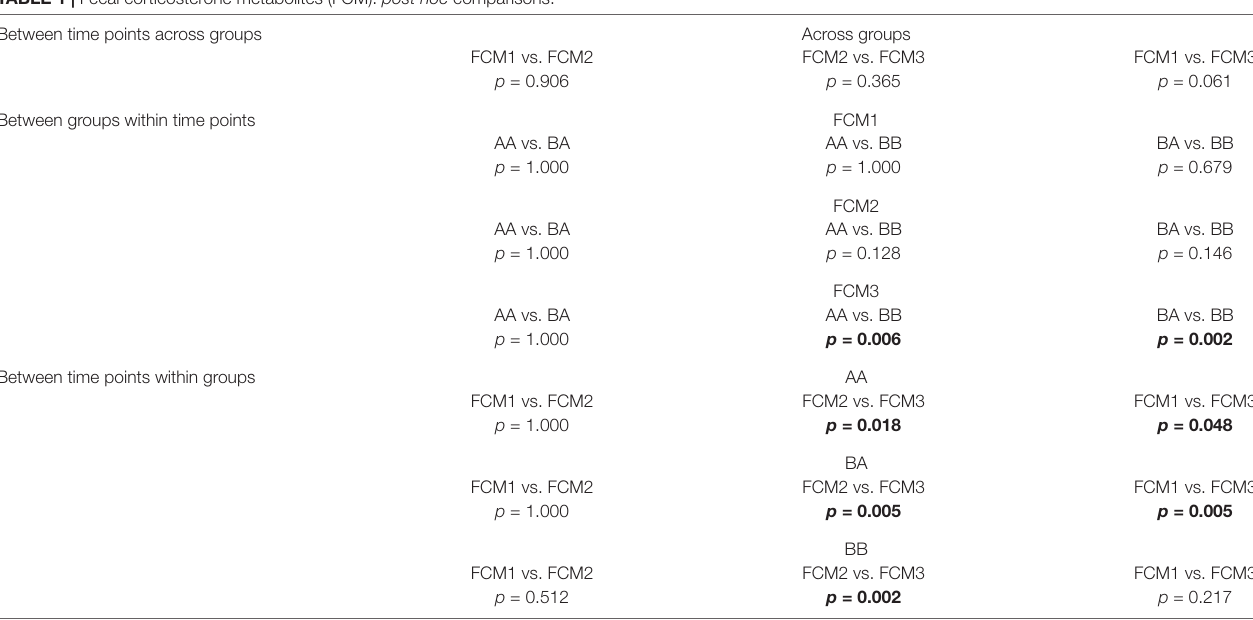
TABLE 1 | Fecal corticosterone metabolites (FCM): post hoc comparisons. Between time points across groups Across groups FCM1 vs. FCM2 FCM2 vs.